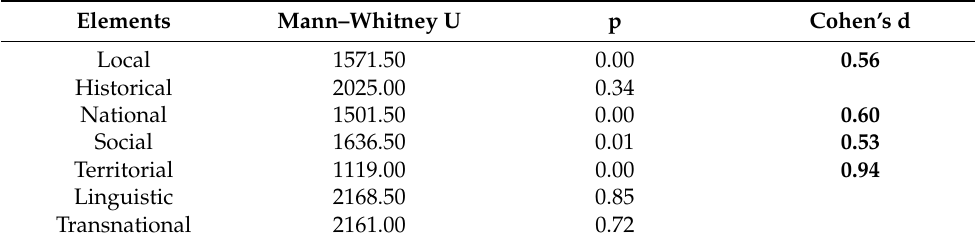
Table 4. Contrast test between the groups with respect to elements that make up identities.